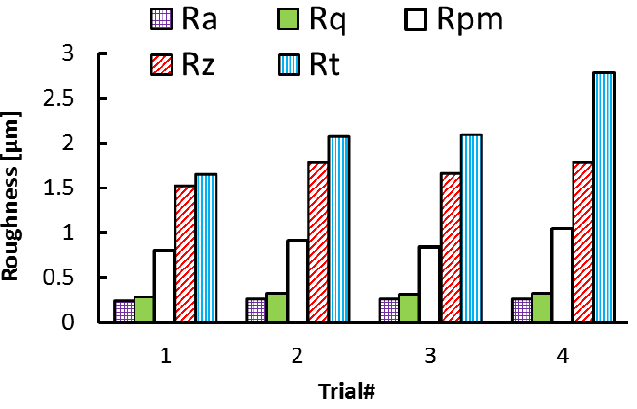
Figure 2. Effect of cutting conditions on height parameters in axial direction.